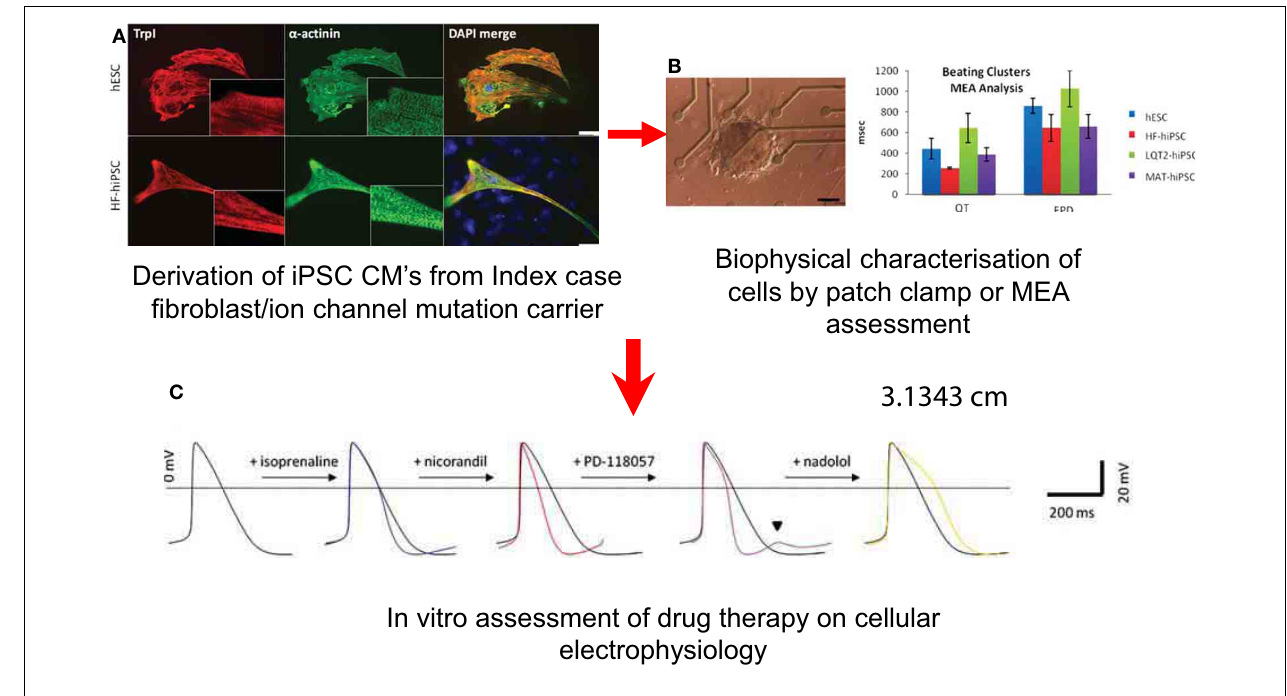
FIGURE 5 | Potential Uses of iPSC-CMs in the Investigation of SADS. Derivation of cells (A) Immunostaining for cardiac troponin I (TrpI) and a-actinin in myocytes derived from hESCs, HF–hiPSC, LQT2–hiPSC, and MAT–hiPSC, showing characteristic cardiac muscle striations. (B) Characterization of cellular electrophysiology: Image of an LQT2–hiPSC beating cluster mounted onto a multi-electrode array for electrophysiology